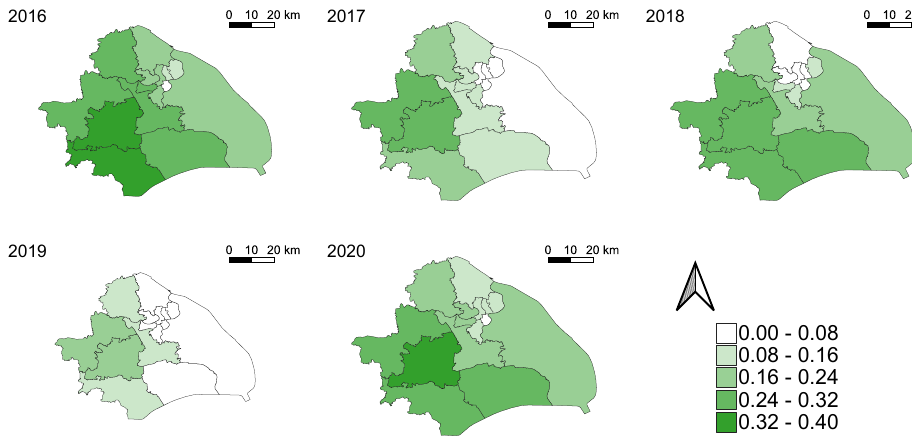
Figure 11. Average value of Greenness in each district.